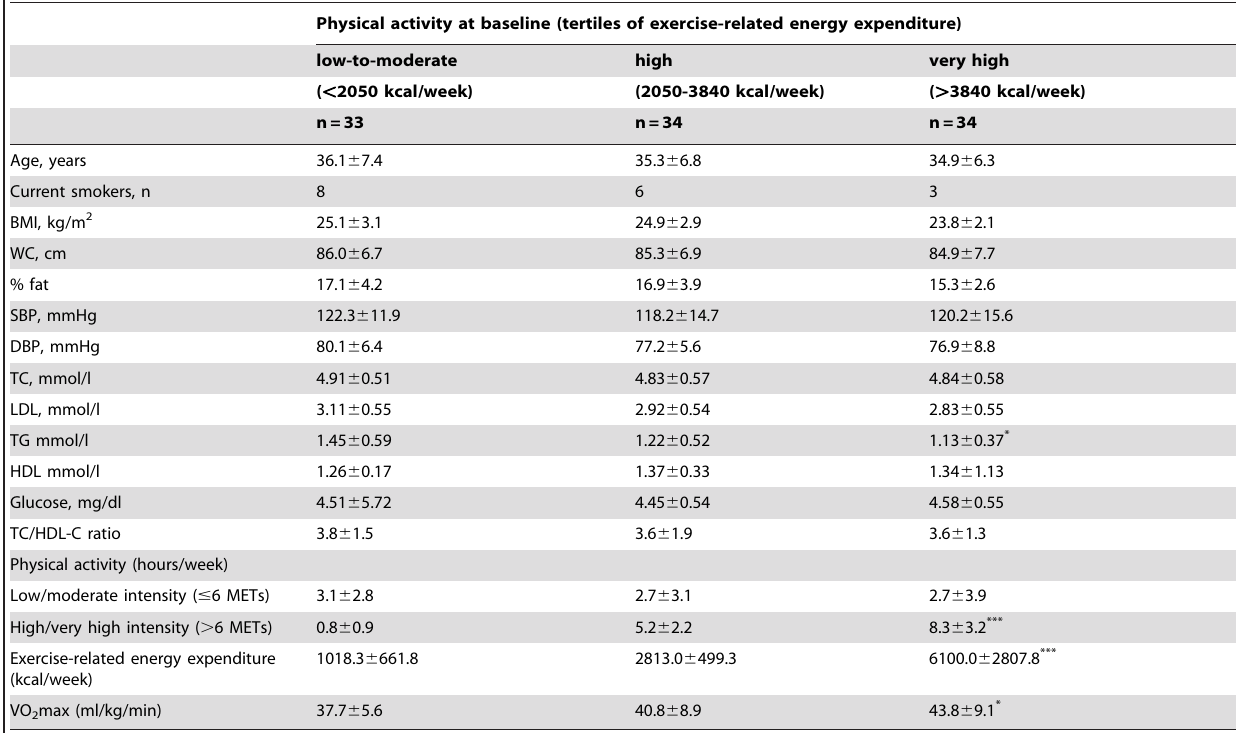
Table 1. Distribution of demographic, lifestyle and clinical characteristics of the studied group at baseline (1985/90) according to physical activity